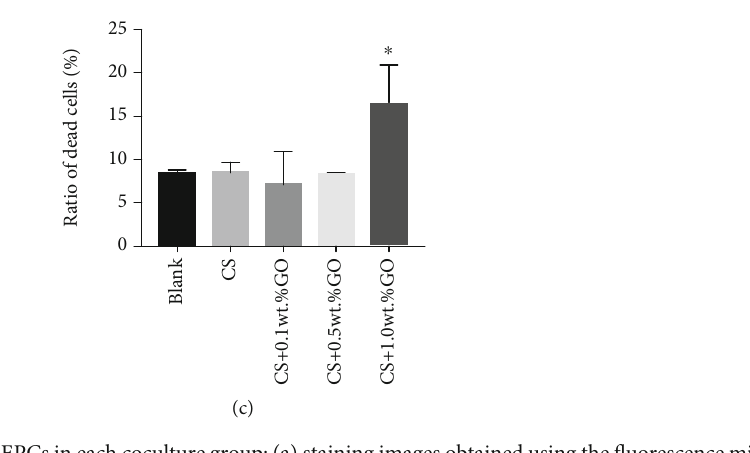
Figure 6: Dead and live cell staining of the EPCs in each coculture group: (a) staining images obtained using the fl uorescence microscope; (b) dead and live cell staining results acquired by FCM; (c) ratio of dead cells in each group. ∗ P < 0 : 05 .